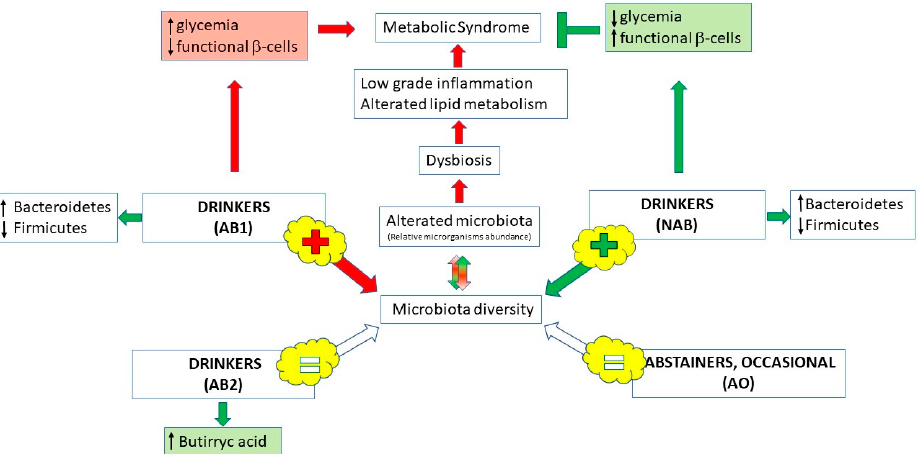
Figure 2. Schematic representation of relationship between beer, gut microbiota and metabolic syndrome. Phenolic compounds contained in non-alcoholic beer have a positive effect on the microbiota dysbiosis, one of the main causes of metabolic syndrome, but the effect is prevented by alcohol presence. Non-alcoholic beer consumption also determines a positive modification of some parameters typical of metabolic syndrome such as glycemia and the β -cells’ function (AB1, drinkers of 355 mL/day of alcoholic beer; NAB, drinkers of 355 mL/day of non-alcoholic beer [111]). On the other hand, moderate beer consumption can increase the production of butyric acid, a fundamental molecule produced by the microbiota and useful for its healthy implications (AB2, drinkers of 200–600 mL/day; AO, abstainers or occasional consumers of <1.5 alcohol g/day [122]).